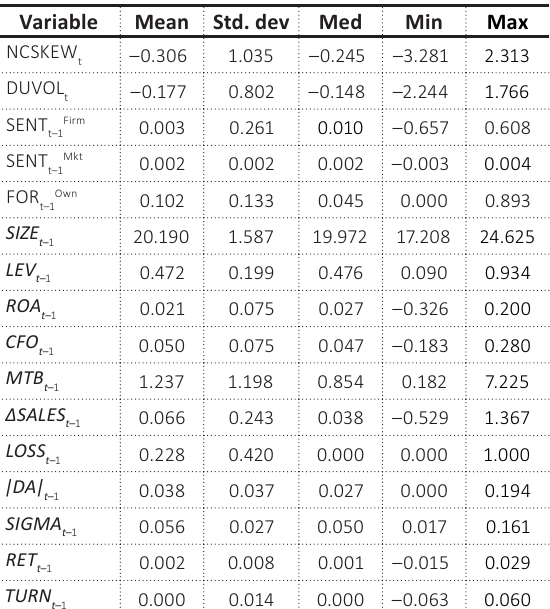
Table 2. Descriptive statistics (n = 5,308)